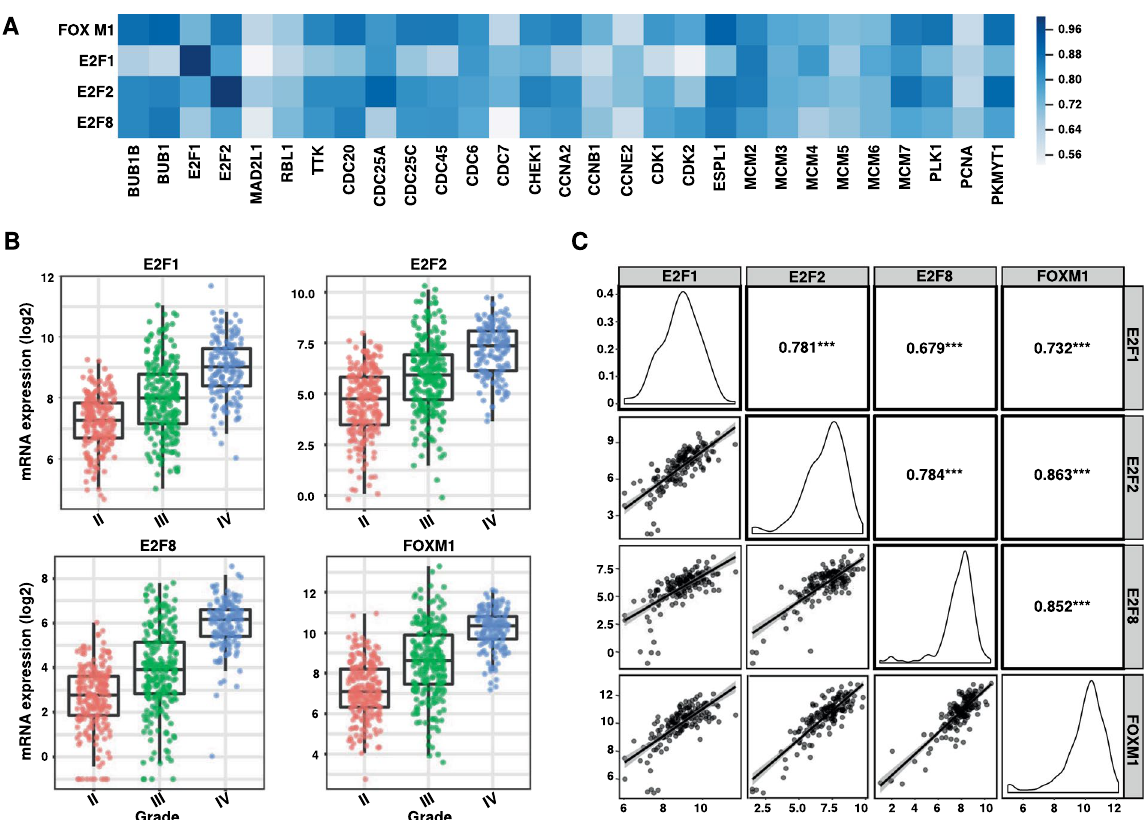
Figure 2. E2Fs and FOXM1 in glioblastoma. ( A ) Correlation of E2F1, E2F2, E2F8, and FOXM1 with target genes involved in cell cycle. ( B ) Expression levels of E2F1, E2F2, E2F8, and FOXM1 in gliomas grades II, III, and IV in TCGA samples. ( C ) E2F1, E2F2, E2F8, and FOXM1 expression correlation in glioblastoma (TCGA samples) using Gliovis 24 . *** p-value < 0.0001.